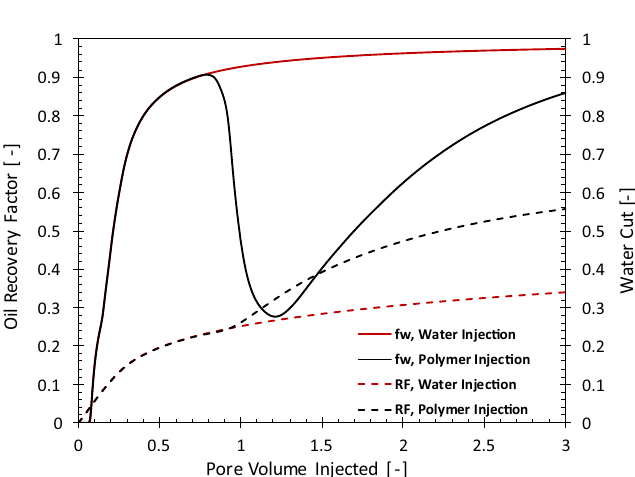
Figure 9. The oil recovery factor (RF) and water cut (f w ) histories for water and surfactant-polymer